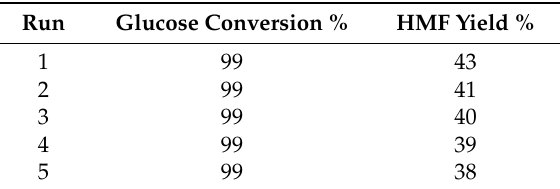
Table 3. Recycling of the